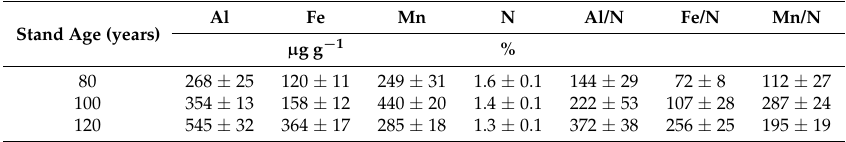
Table 3. Leaf nutrient content expressed on leaf dry mass base and with respect to nitrogen ratio. Mean value ± standard error ( n = 5).